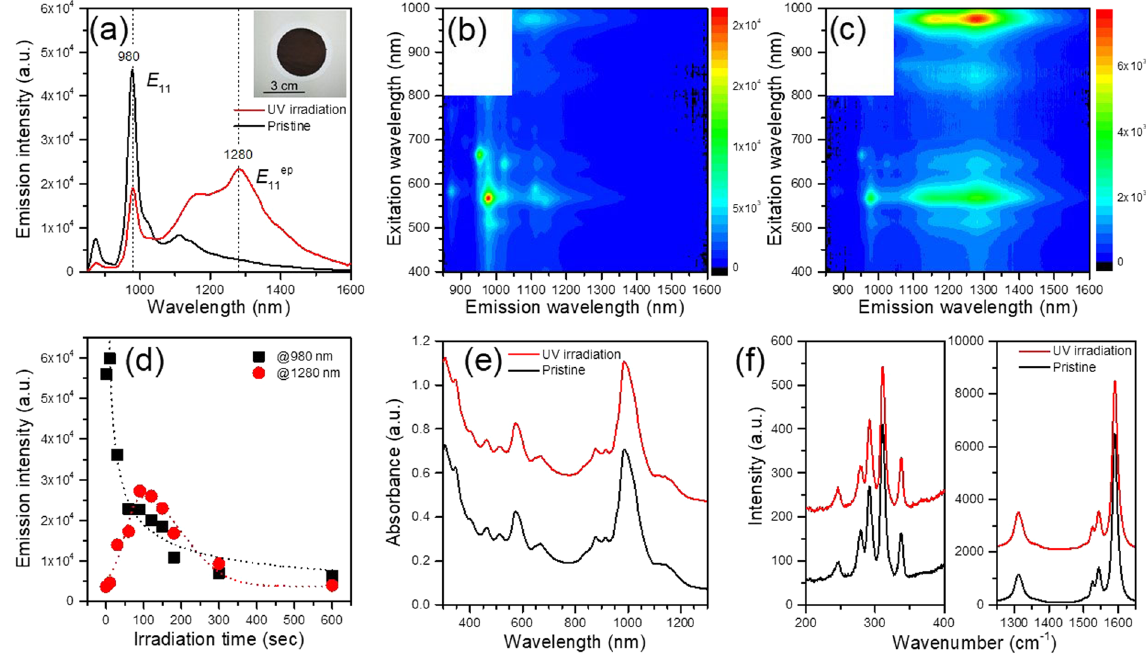
Figure 1. Spectral changes of SWCNTs after exposure to UV-ozone process. ( a ) PL spectrum obtained from SDBS-D 2 O solution of SWCNTs after UV irradiation for 90 sec (red line), together with reference spectrum of pristine SWCNT-SDBS-D 2 O solution (black line). Excitation wavelength = 570 nm. (inset) Image of treated SWCNT thin film. ( b ) 2D excitation-emission contour plots of ( b ) pristine and ( c ) treated SWCNTs. ( d ) UV- irradiation time dependence of PL intensities of E 11 at 980 nm (black) and that of epoxide adducts at 1280 nm (E 11ep ) (red). ( e ) Absorption spectrum of processed SWCNTs after 90-sec UV irradiations (red), together with reference spectrum of original SWCNTs (black). ( f ) Resonance Raman spectrum of treated SWCNTs after 90- sec irradiations (red), together with reference spectrum of pristine SWCNTs